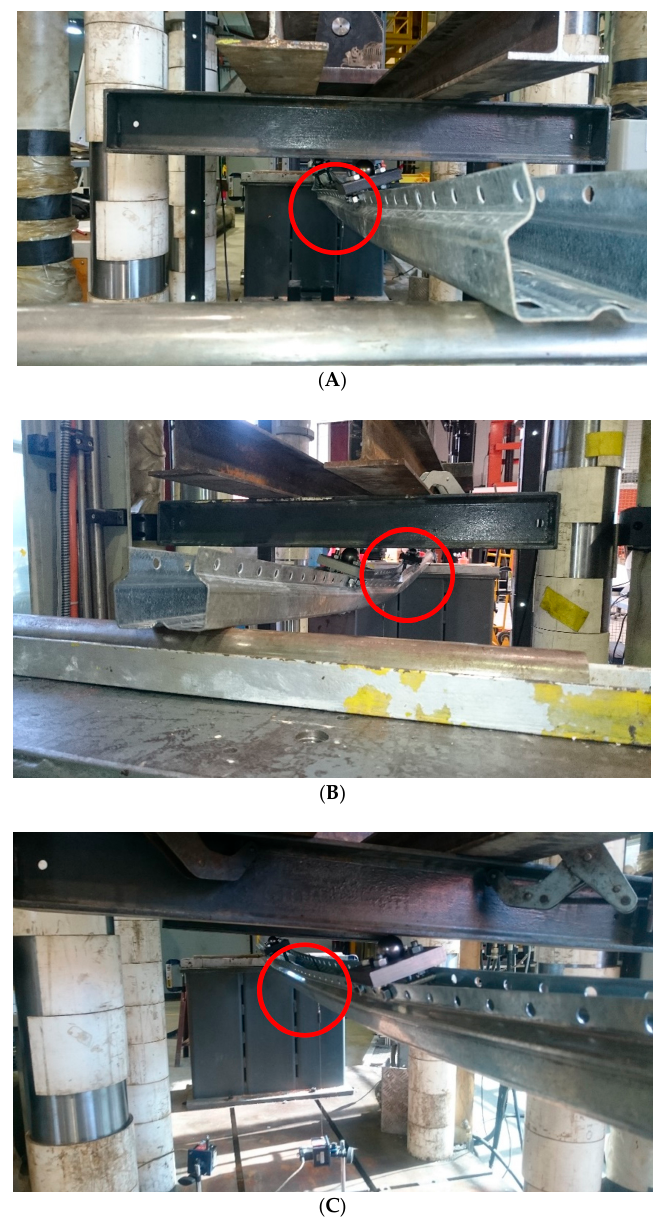
Figure 17. The observed failure mode for unreinforced specimens during the minor axis test: ( A ) SMIM-test1; ( B ) SMIM-test2; ( C ) SMIM-test3.